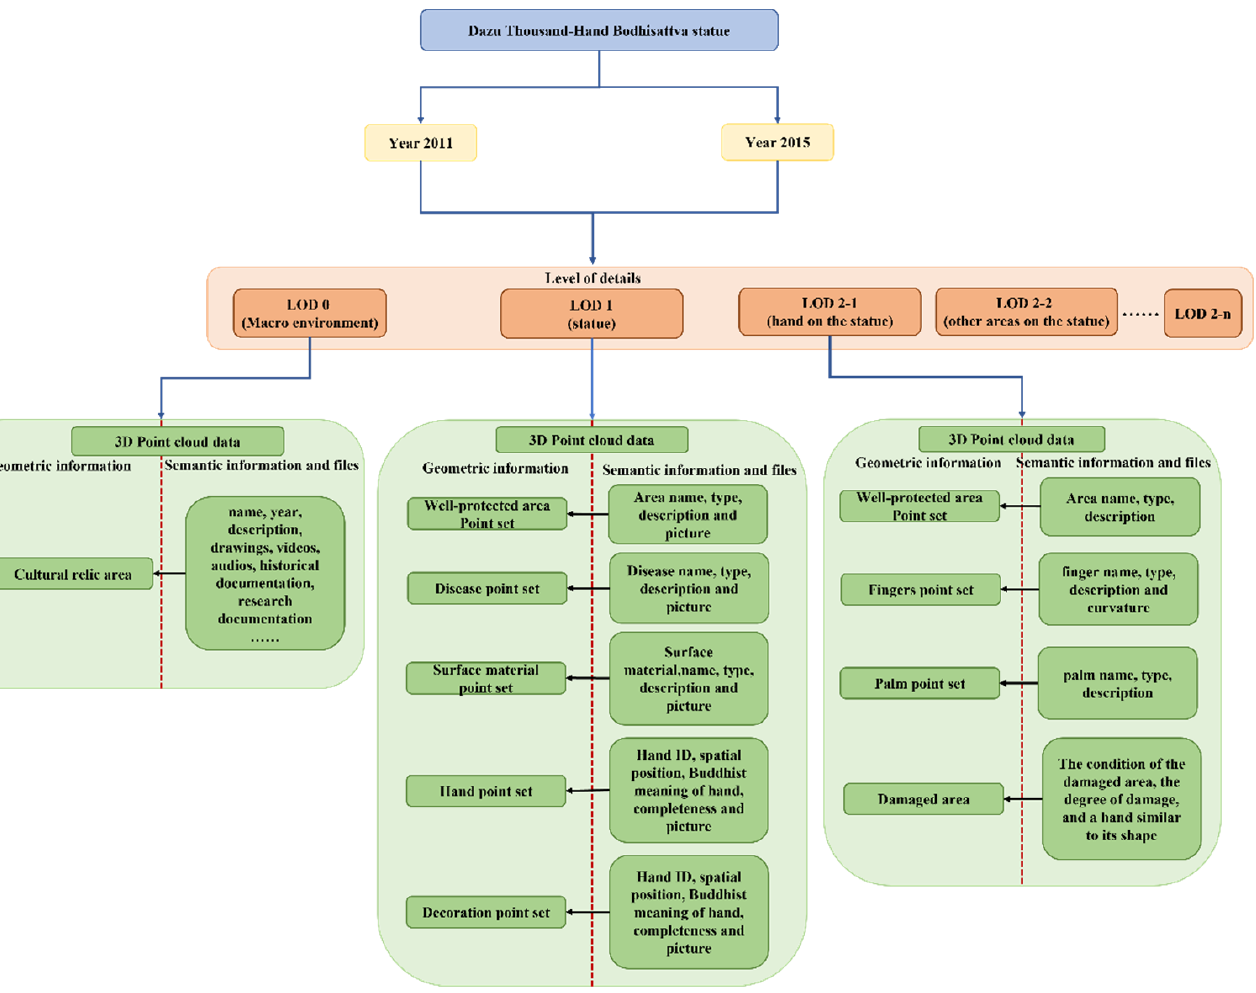
Figure 4. The framework of the smart point cloud for The Dazu Thousand-Hand Bodhisattva Statue.